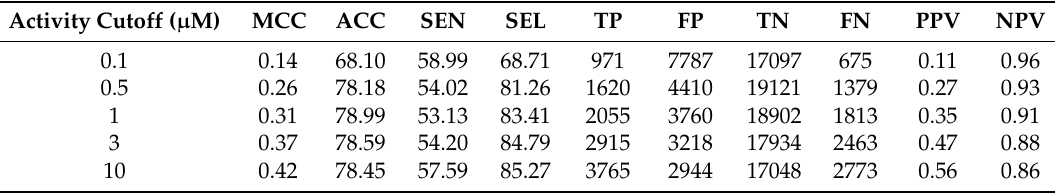
Table 1. Quality metrics for five artificial neural network (ANN)